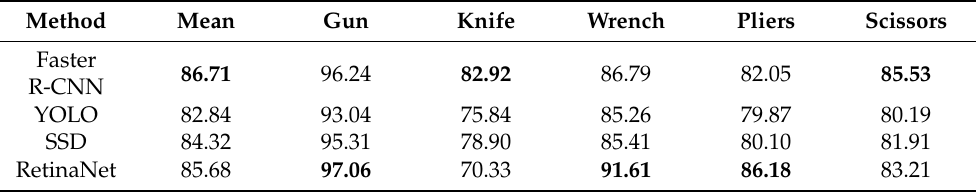
Table 2. Detection mean average precision (%) on the validation